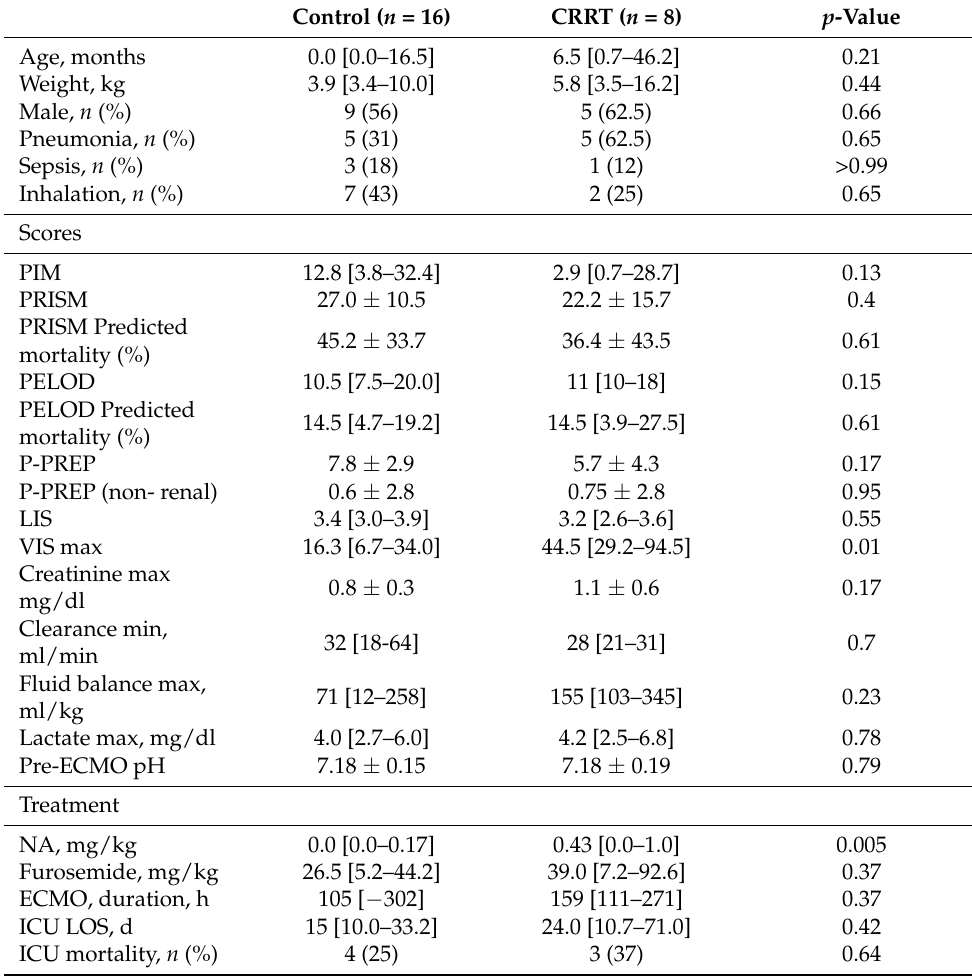
Table 4. Statistics after propensity score